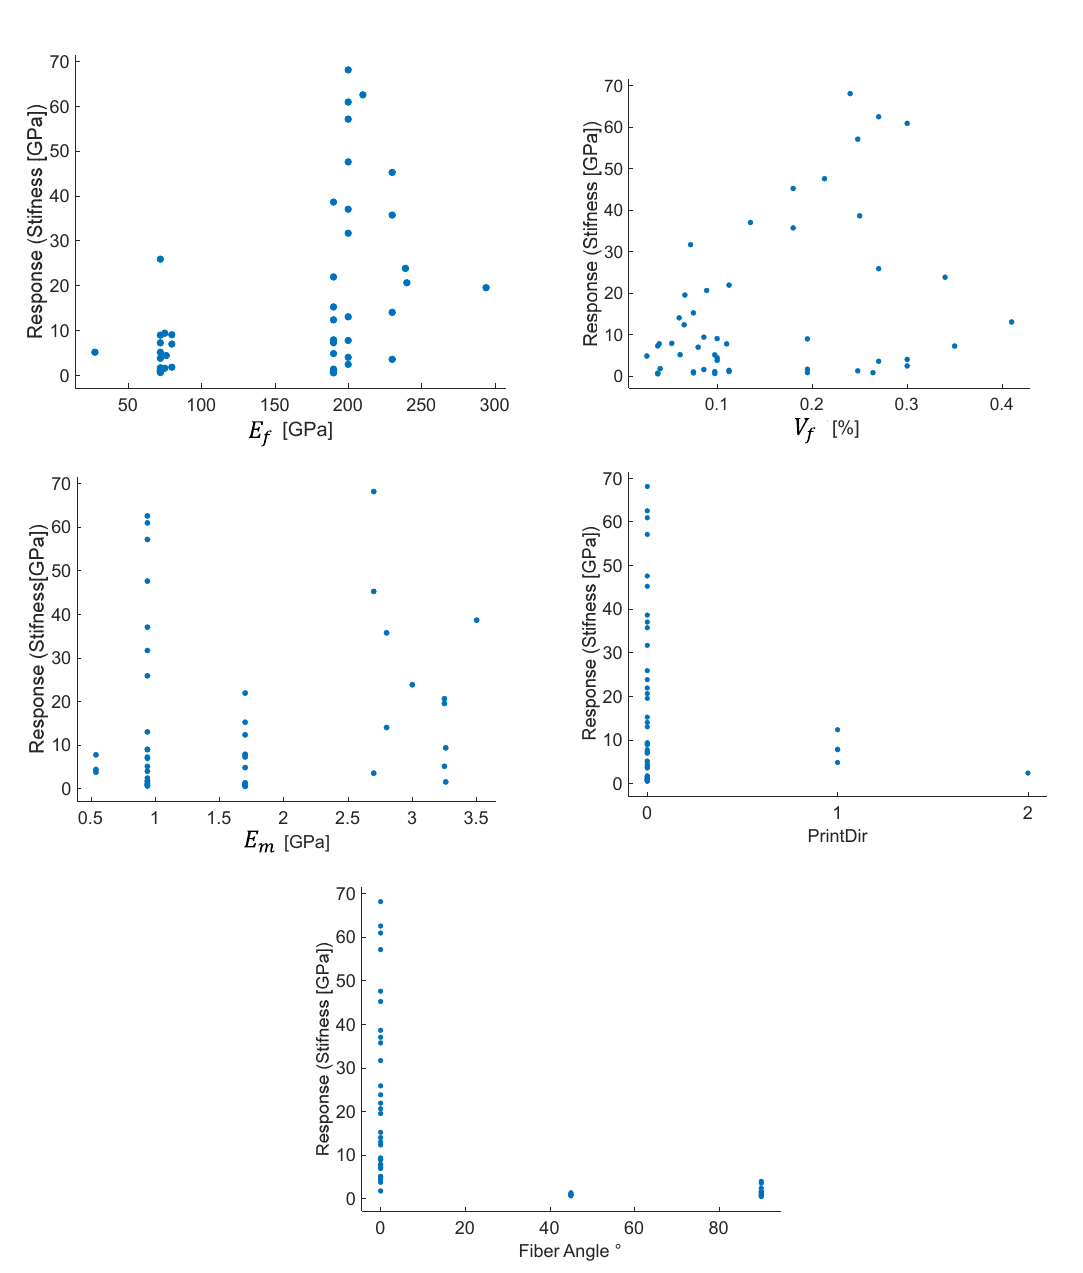
Figure 7. Response plots of the stiffness for five factors of the FRAM. The models were evaluated according to four performance metrics: root mean square error (RMSE), the coefficient of determination R ‐ squared, the prediction speed, and the training time. R ‐ squared is a number always smaller than one and usually larger than zero, comparing the constant average model with the trained model. Thus, the R ‐ squared is negative if the predicting model is worse than a constant model. Table 7 resumes the model performance for the stiffness and strength response. Table 7. Comparative table for the predicting model performance.